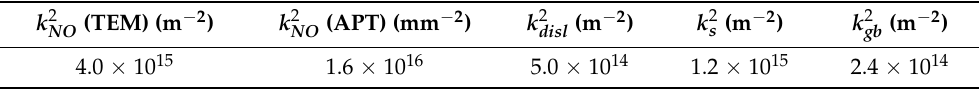
Table 8. Sink strength values for nano-oxides, dislocations, free surface and